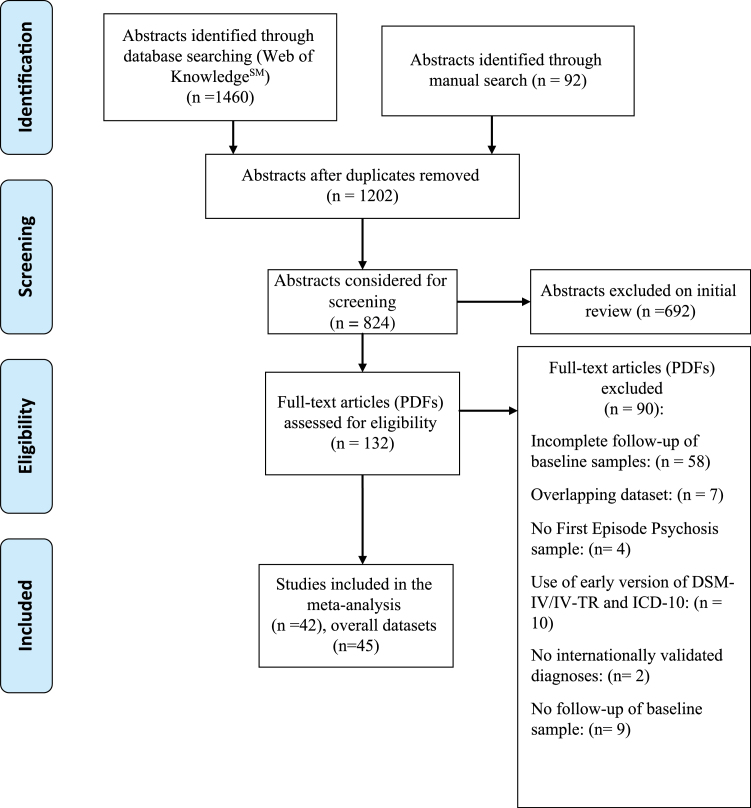
PRISMA Flow Chart.